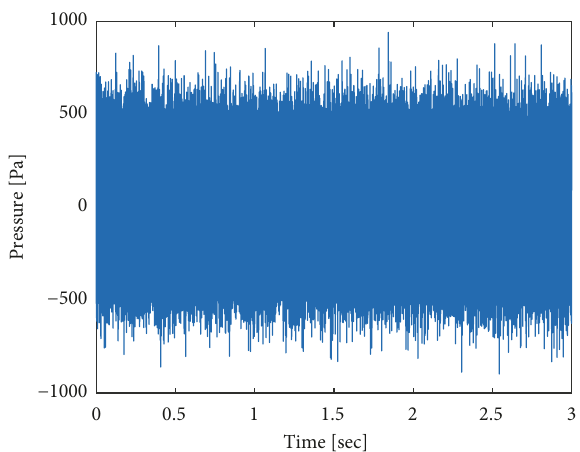
Figure 3: Time history of random acoustic load ( SPL = 110 dB ).